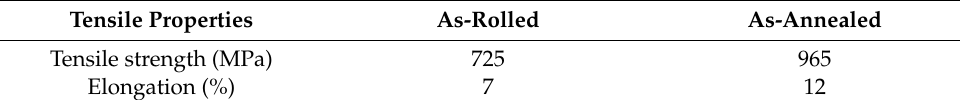
Figure 11. The typical tensile curve of solution-treated and as-annealed samples of the Cu–6Ni–6Sn–0.6Si alloy. Table 2. Average tensile properties of Cu-6Ni-6Sn-0.6Si alloy.